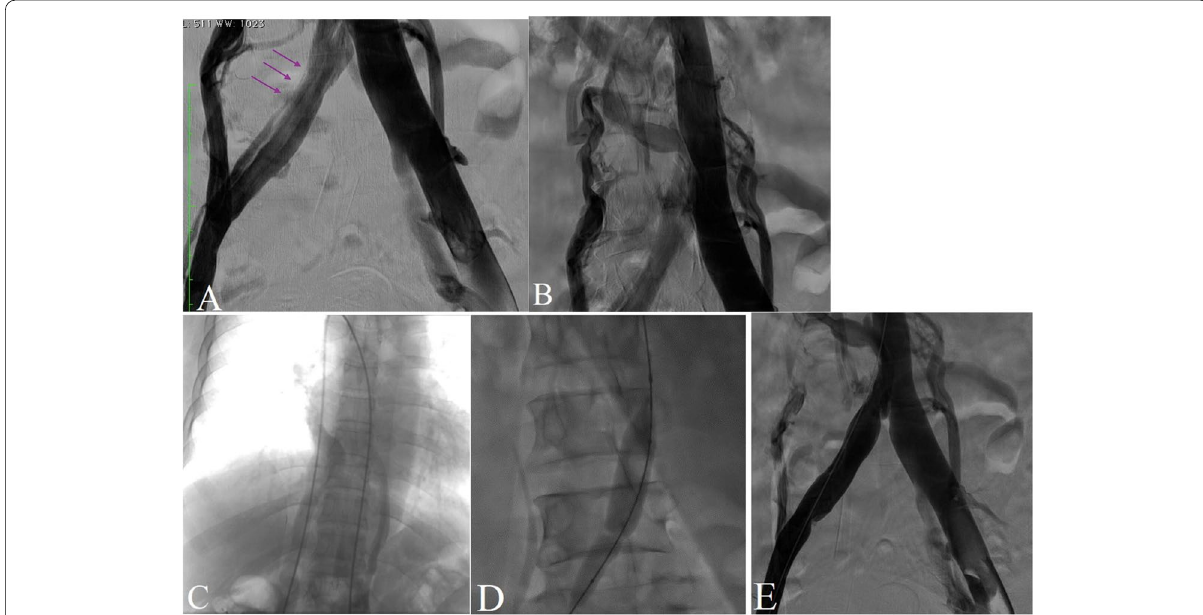
Fig. 2 The images depict the patient’s venography (upper images) and venoplasty (lower images). In figure “ A ” the arrow shows compression on right iliac vein and in “ B ” the IVC anomaly is imaged and in “ C ” the wire path shows the connection of left sided IVC with hemiazygus vein and in “ D ” we perfomed a prolonged balloon inflation and “E” demonstrates the final acceptable angioplasty